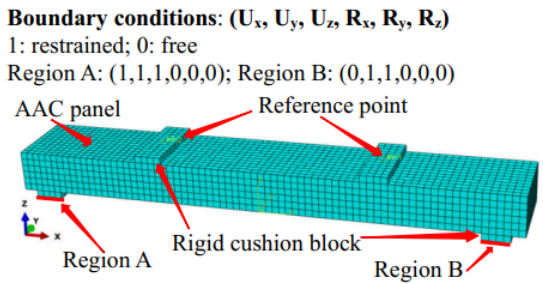
Figure 12. Finite element model of the specimen.